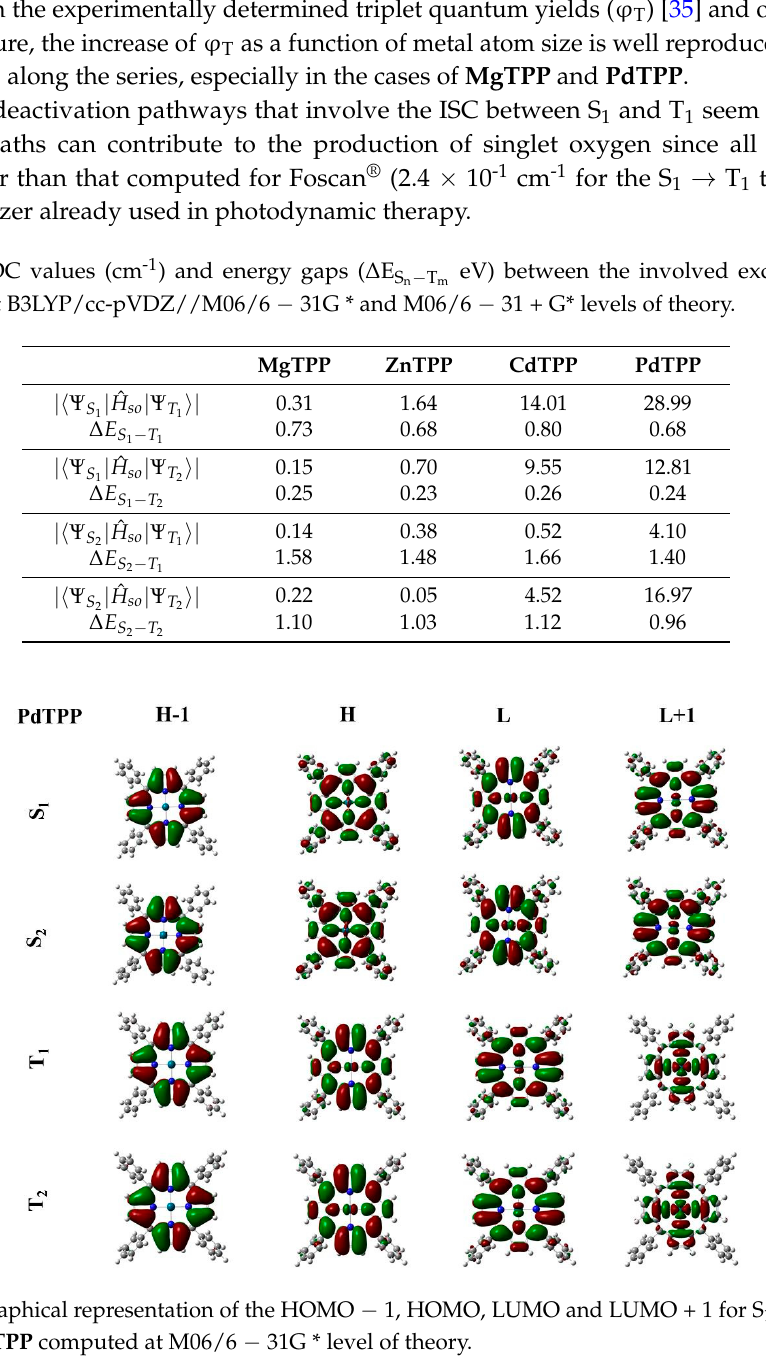
Figure 1. Graphical representation of the HOMO − 1, HOMO, LUMO and LUMO + 1 for S 1 , S 2 , T 1 , T 2 states of PdTPP computed at M06/6 − 31G * level of theory.